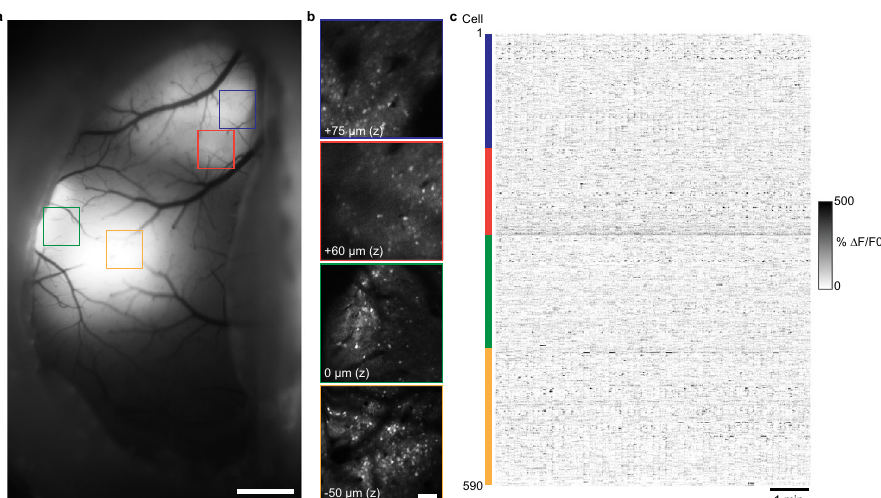
Fig. 2 Quad area two-photon calcium imaging of jYCaMP1s in sensorimotor cortex in the awake mouse using a 1040 nm laser source. a Wide- fi eld fl uorescence image of mouse sensorimotor cortex showing jYCamp1s expression through an implanted crystal skull. b Two-photon images of the regions expressing jYCamp1s displayed in ( a ) acquired with the Quadroscope. Imaging depth re fl ects relative focal plane positioned with each electrically tunable lens at the imaging region. Images in ( a ) and ( b ) have been obtained from fi ve animals with similar results. c Calcium transients in the awake animal from cortical neurons imaged across the four areas in ( b ), simultaneously acquired at 30 Hz. Scale bars: 1 mm ( a ), 100 µ m ( b